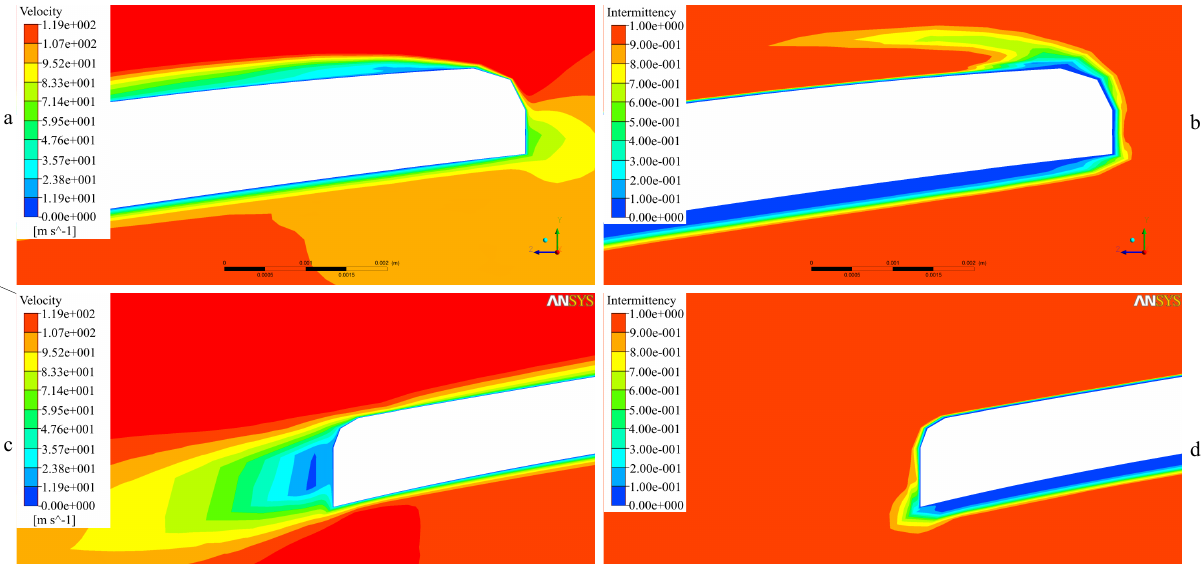
Figure 16. Velocity and intermittency contours at the tip for operation Re = 1.15 × 10 5 . ( a ) Ve- locity at the leading edge, ( b ) intermittency at the leading edge, ( c ) velocity at the trailing edge, ( d ) intermittency at the trailing